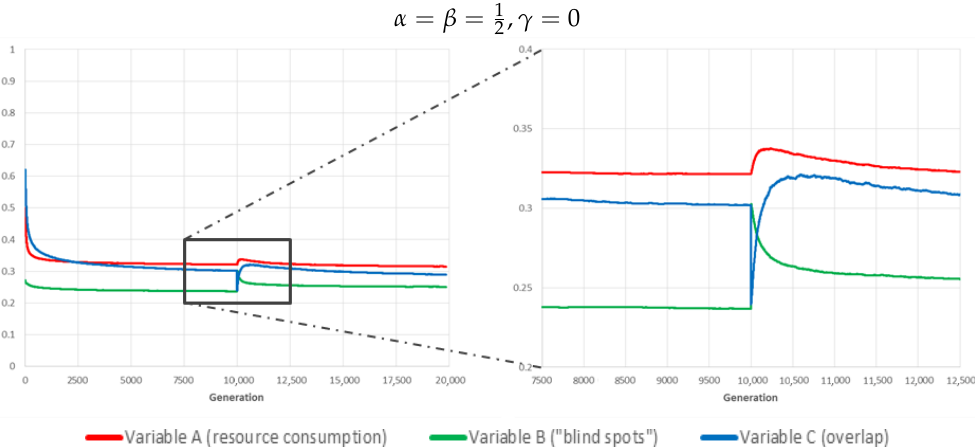
Figure 9. Response to a disruptive event (failure of 8 out of 64 cameras at generation 10,000). The curves show the evolution over time of the three global variables for the fittest individual of each generation (averaged over 180 independent